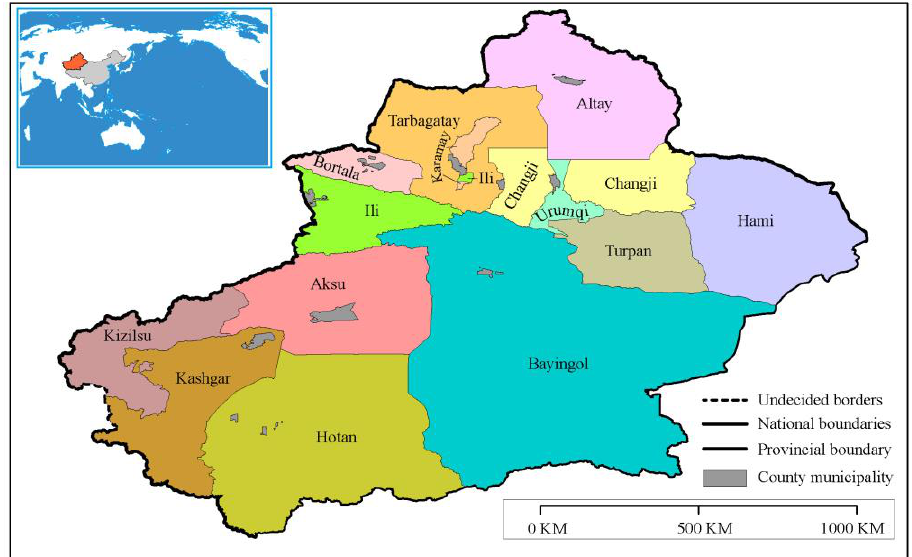
Figure 1. Location of the study area: Xinjiang. Data Resource: modified from Gaode Map, https: //lbs.amap.com, accessed on 9 March